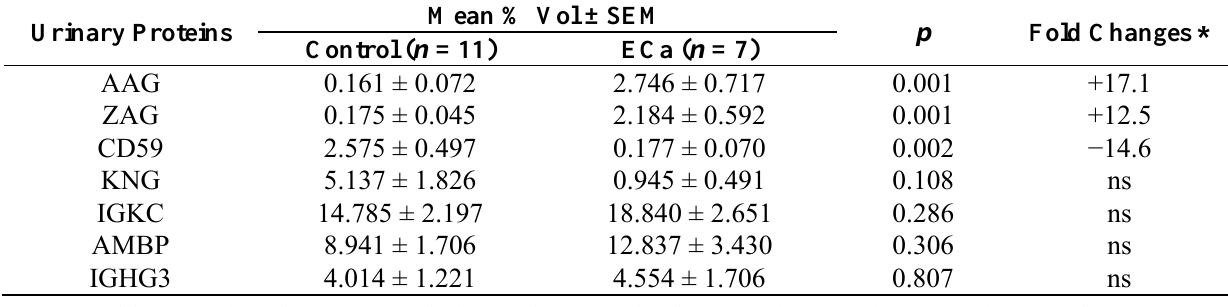
Table 2. Mean percentage of volume contribution of urinary proteins.